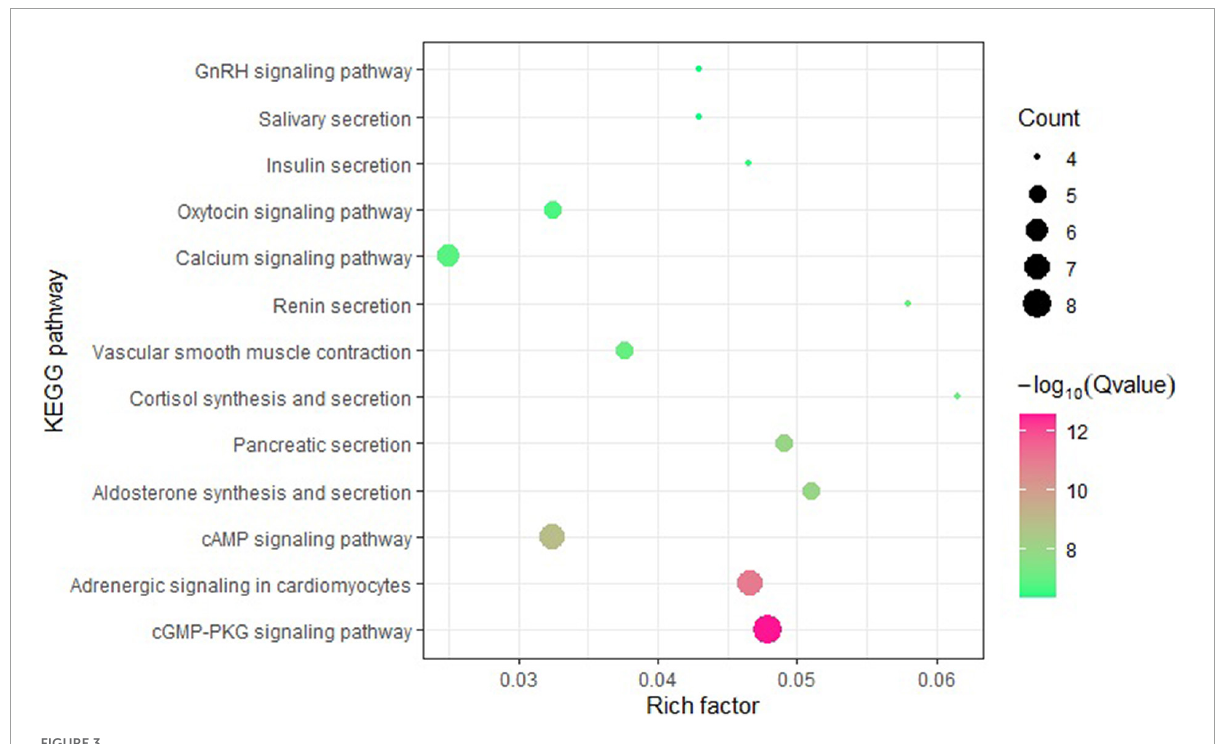
FIGURE3 Bubble chart of enrichment analysis of shared